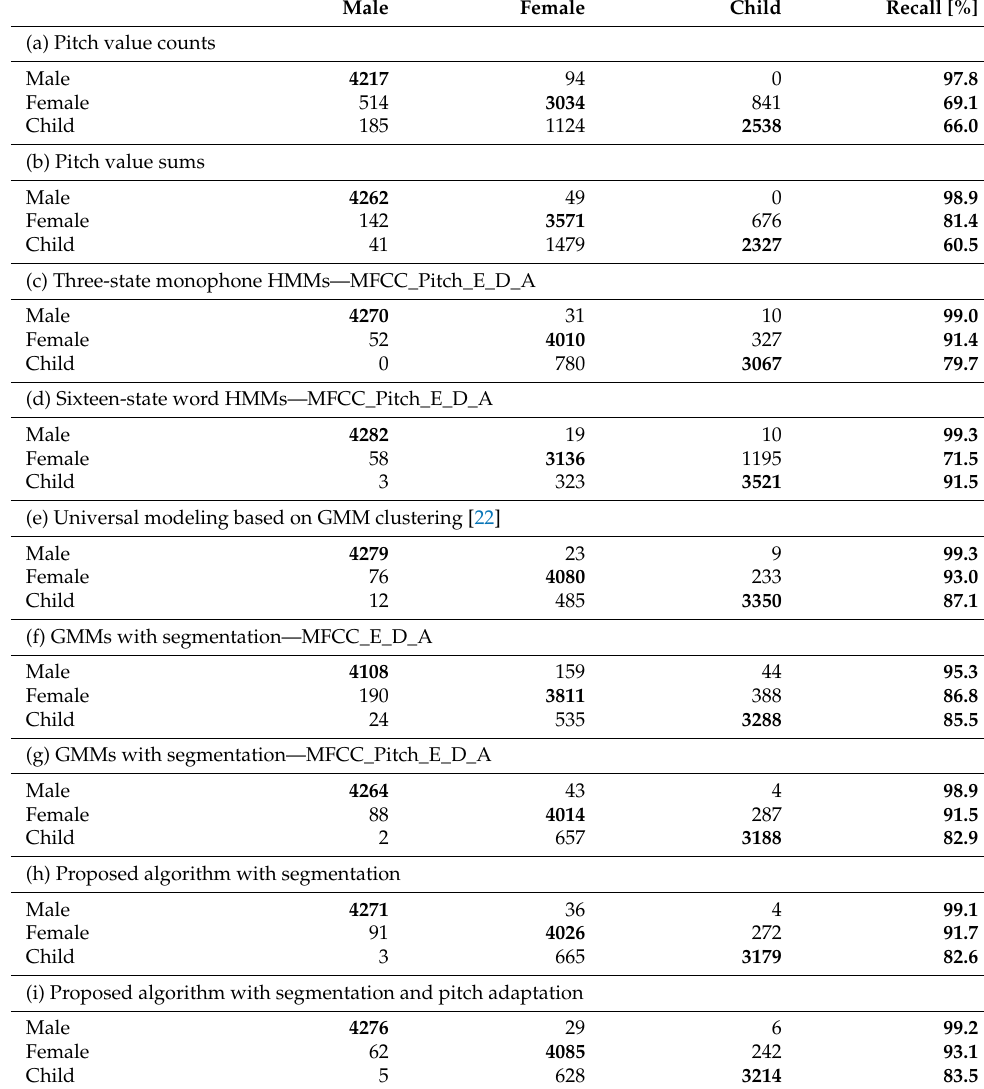
Table 3. Confusion matrix results obtained by gender and age classification with recall